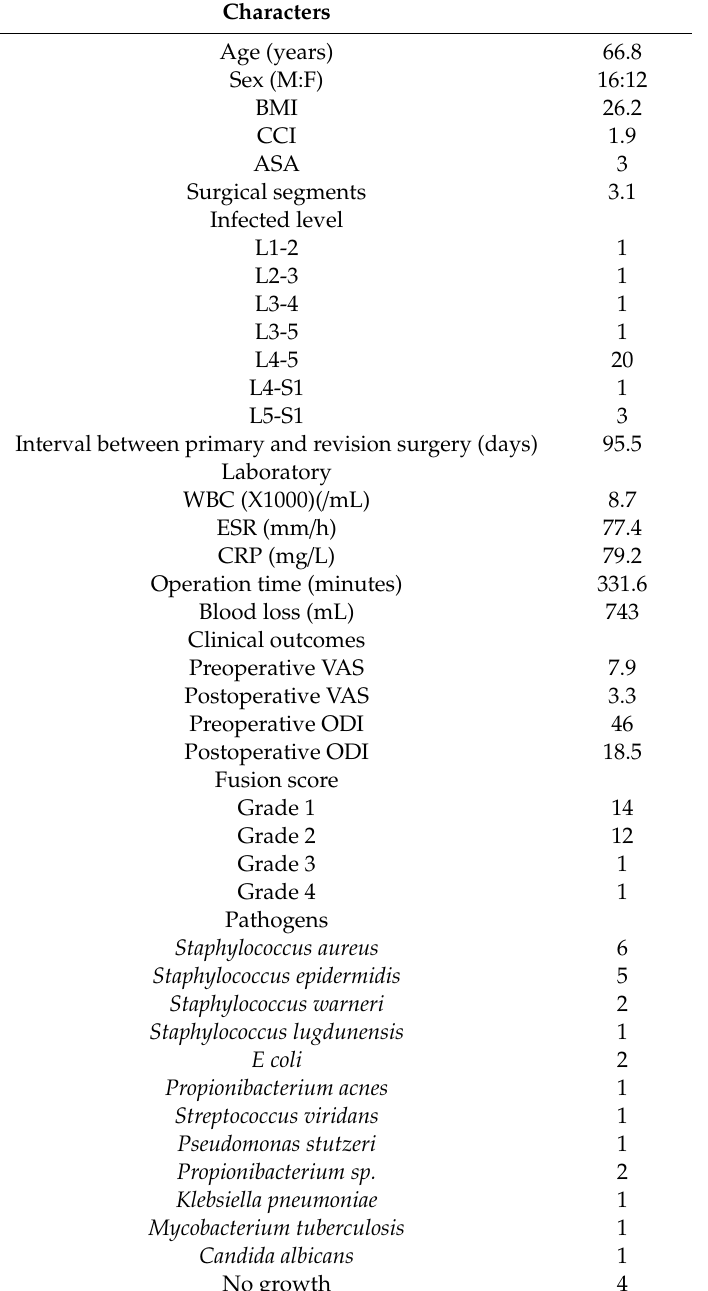
Table 1. Demographic data of total 28